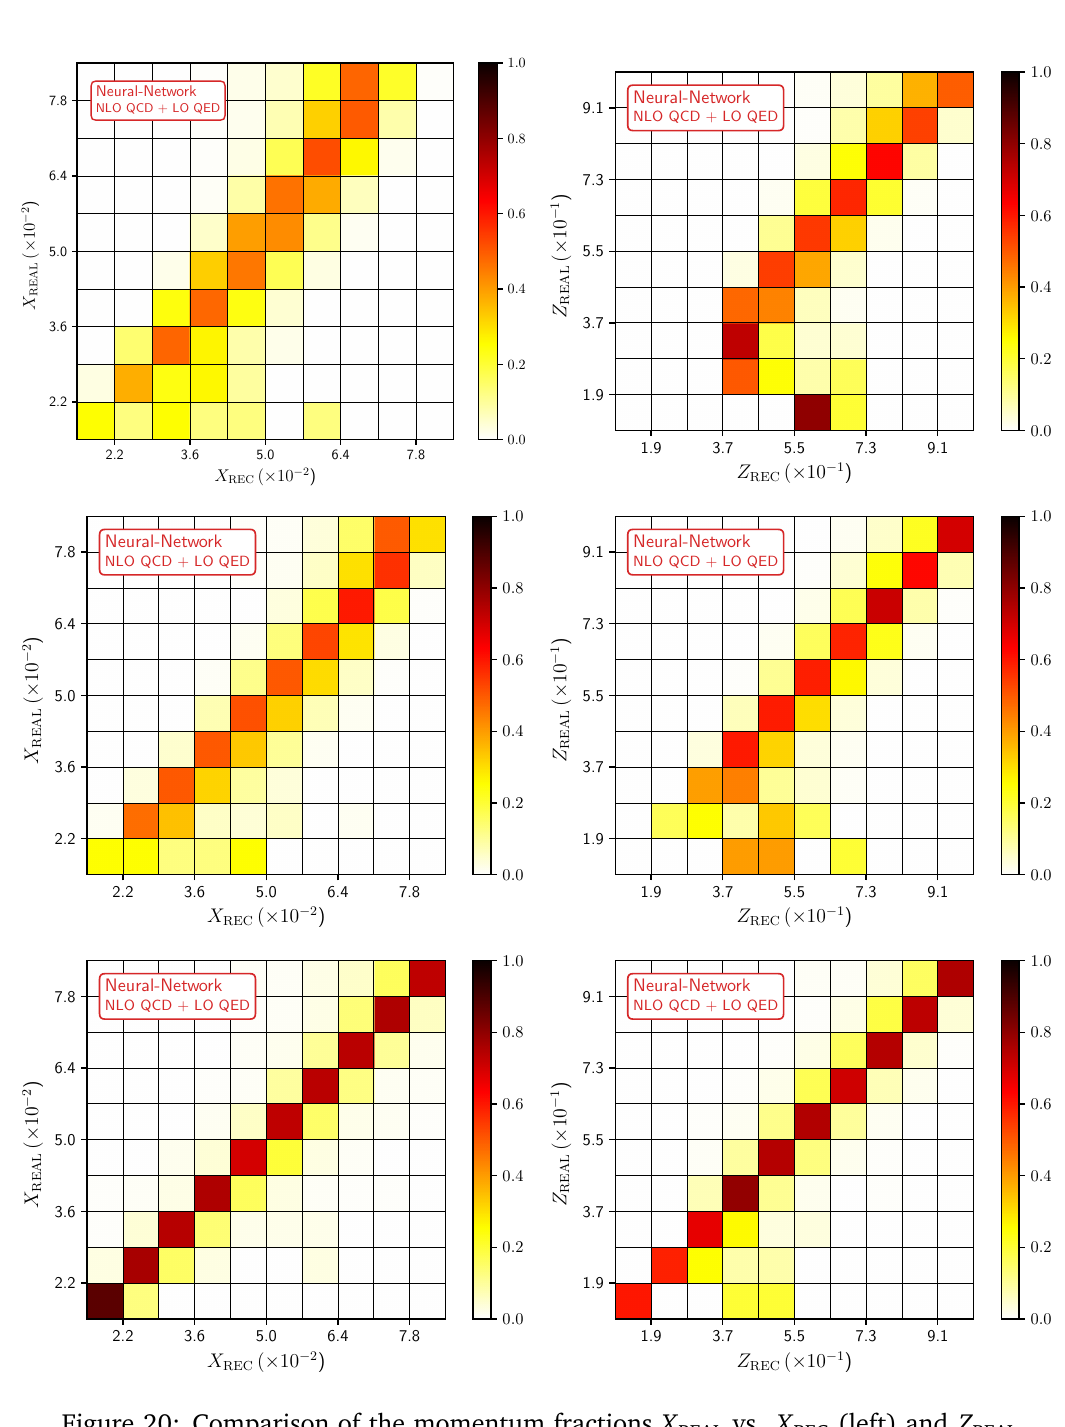
Figure 20: Comparison of the momentum fractions X vs. Z (right) obtained with MLP at NLO QCD + LO QED accuracy. The parameters REC for TEST1 (upper row), TEST2 (middle row) and TEST3 (lower row) are given